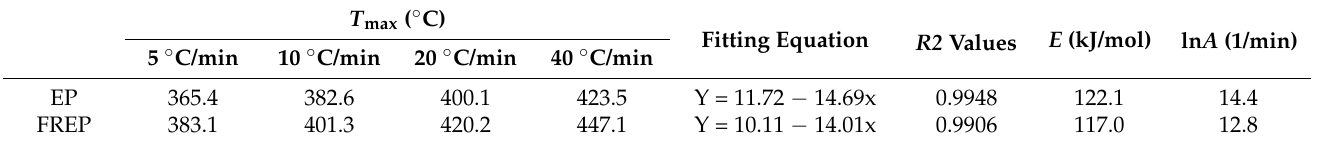
Figure 5. TGA and DTG curves of ( a ) EP and ( b ) FREP composites. As far as the results of the Kissinger method were concerned, the E and ln A values of degradation for the EP composites were determined from the slope and intercept of the ) vs. 1/ T ln ( β / T 2 max linear equations (Figure 6), respectively, presented in Table 2. max Table 2. Kinetic parameters for the degradation of EP and FREP by the Kissinger